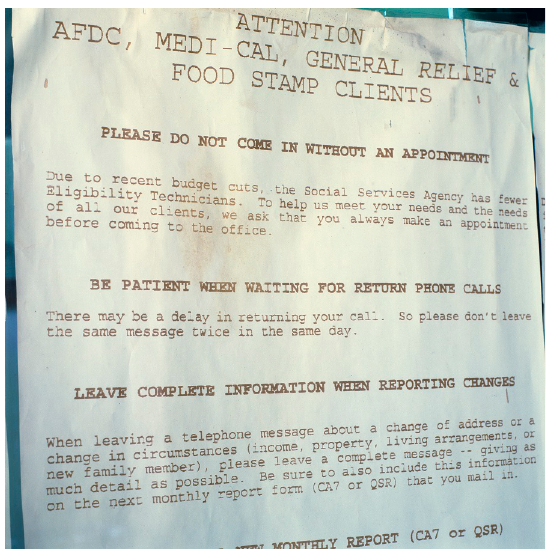
Figure 25. Anthony Hernandez, Waiting in Line #22 (1996), © Anthony Hernandez.